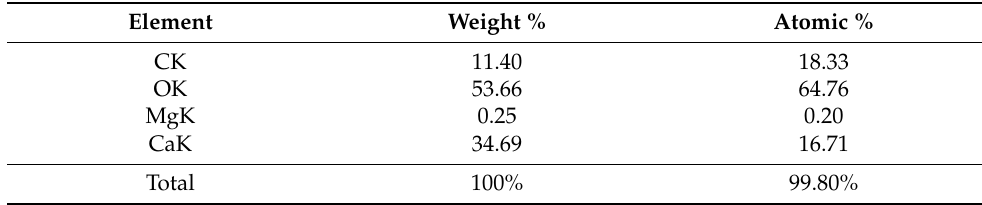
Table 2. The first letter — C, O, Ca and Mg — denotes elements identified during the EDX examination, while the second letter, K, denotes the shell of the element. Table 2. Energy dispersive X-ray test